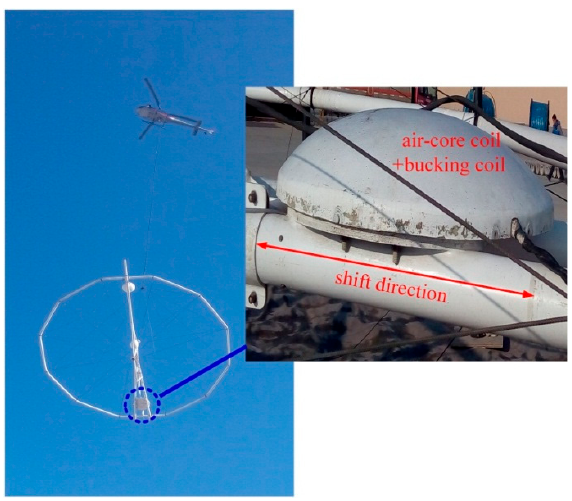
Figure 14. Helicopter TEM system and magnetic flux compensation structure.